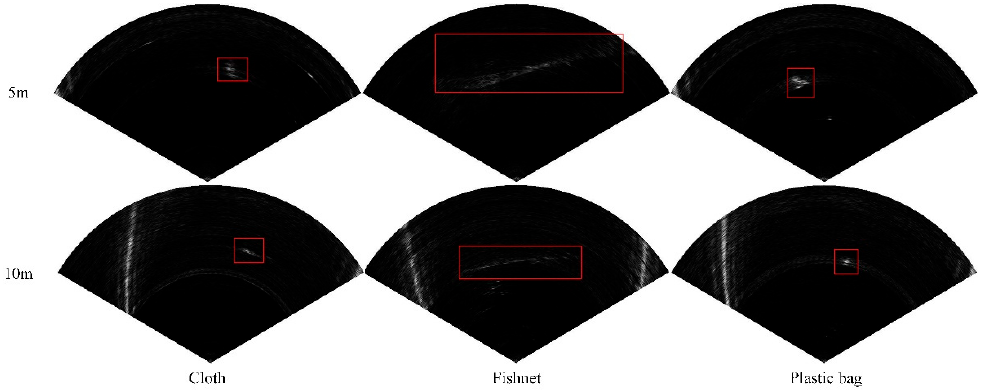
interpolation ( right ).